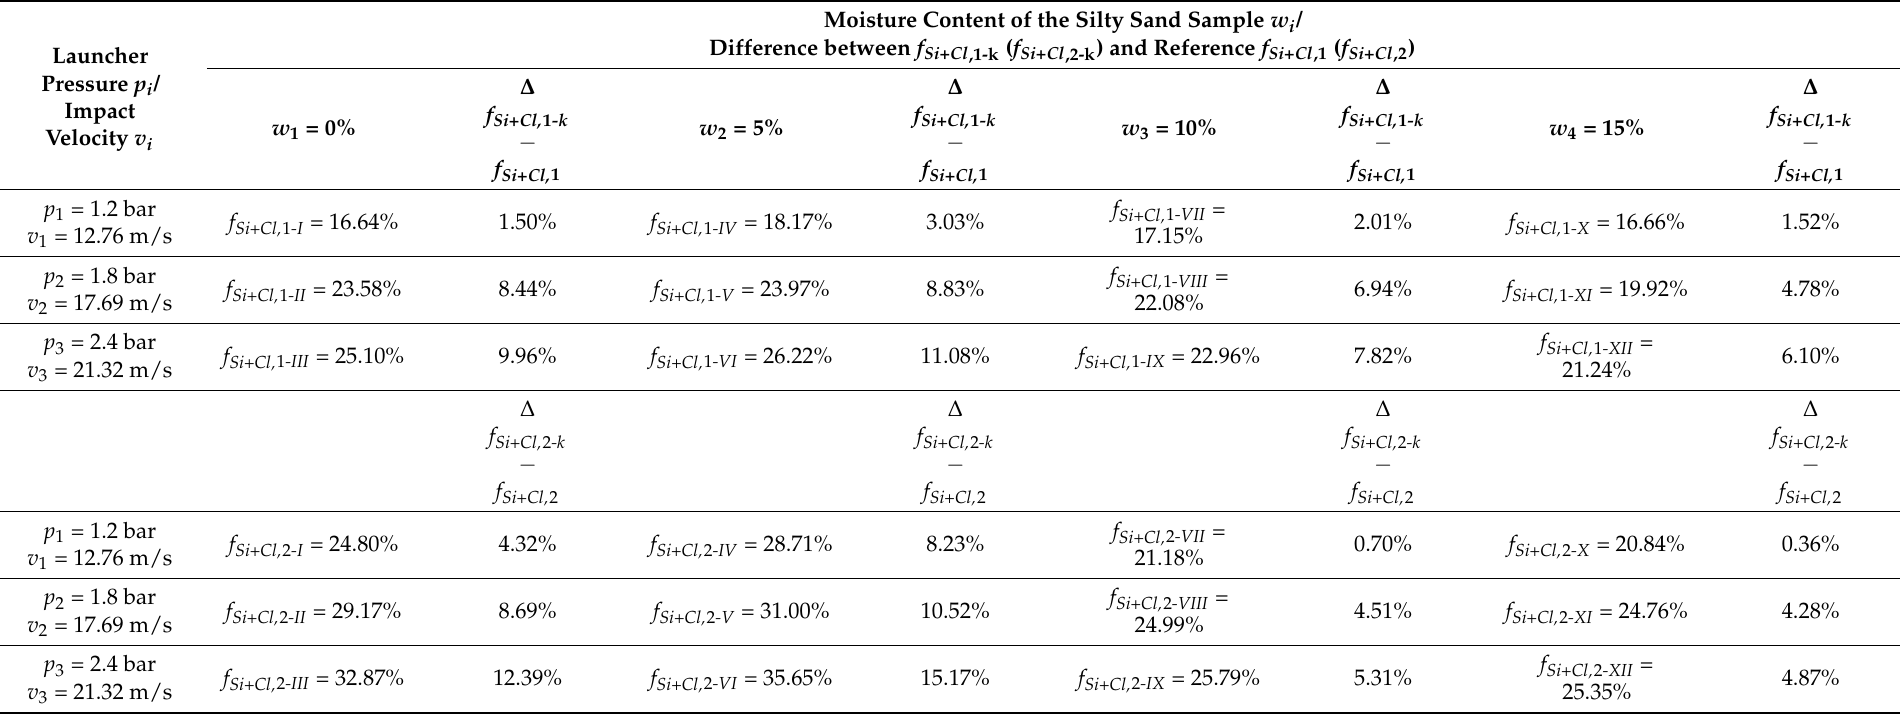
Table 6. Summary of percentage changes in silt and clay fraction as a consequence of bar projectile impact during SHPB testing compared to the f Si+Cl